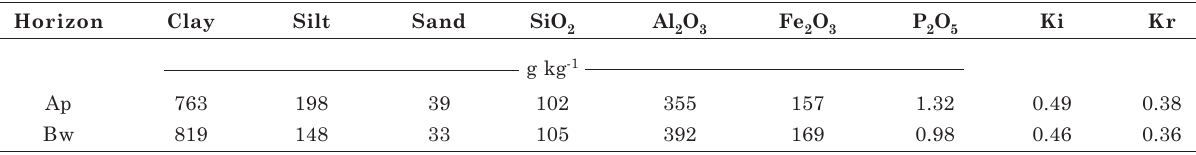
Table 1. Chemical (sulfuric acid digestion) and physical (soil fractions) characteristics of the “Ap” and “Bw” horizons of an